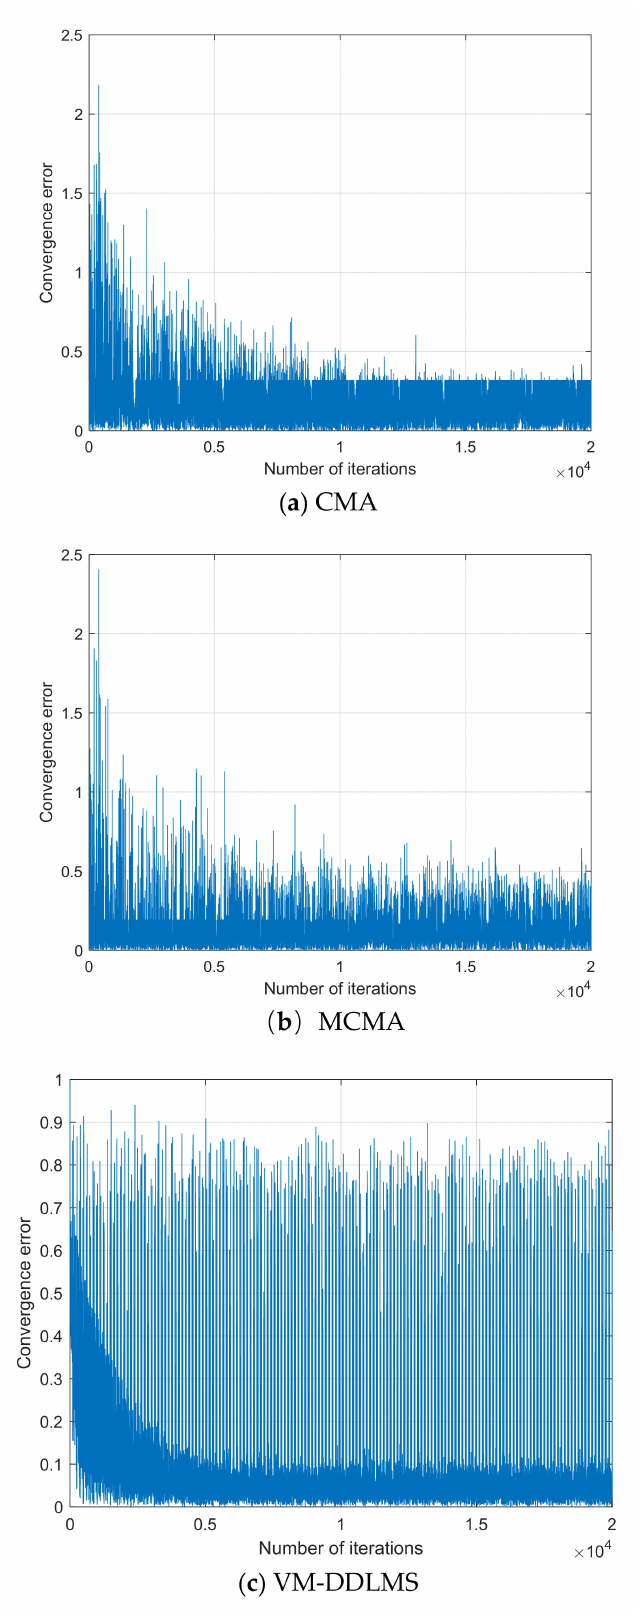
Figure 6. ( a ) CMA algorithm error convergence curve; ( b ) MCMA algorithm error convergence curve; ( c ) VM-DDLMS algorithm error convergence